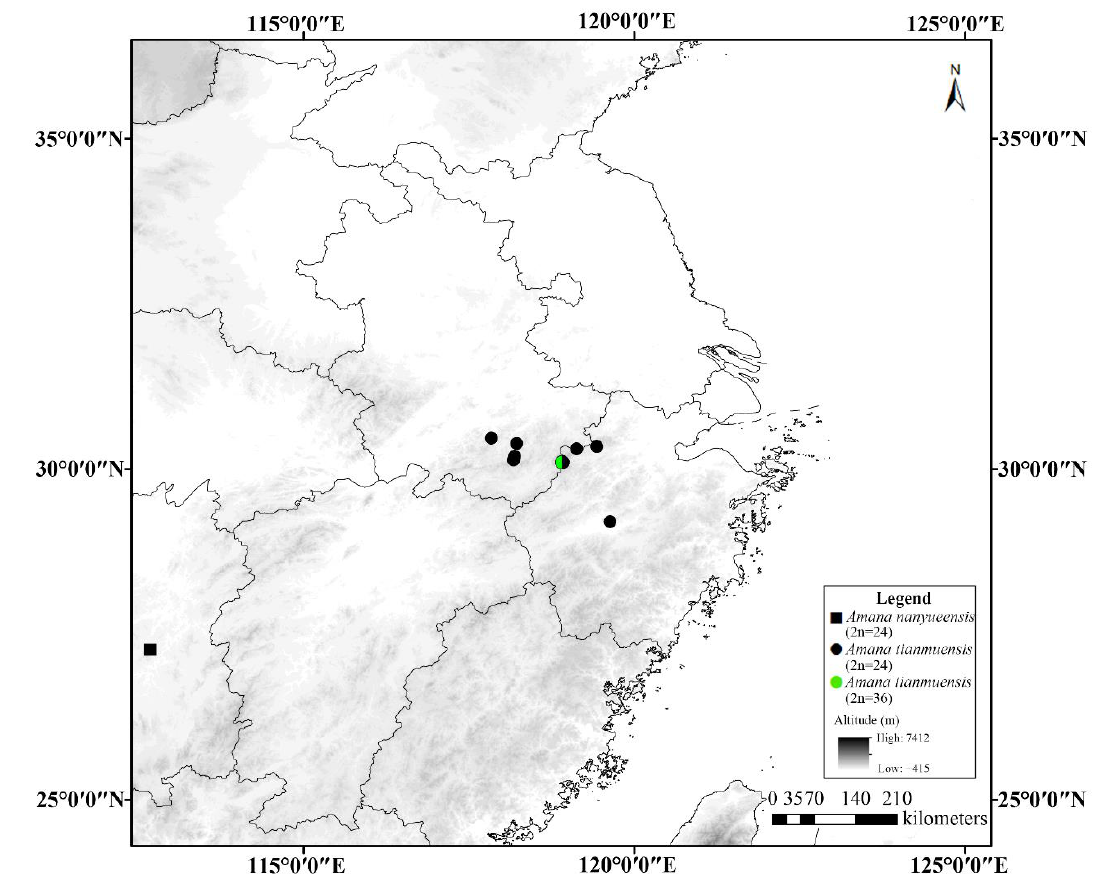
Figure 3. Distribution of ploidy levels of Amana nanyueensis and A. tianmuensis in Anhui province and Zhejiang province. The green color represents triploid (2 n = 3 x = 36) and the black color represents diploid (2 n = 2 x = 24).